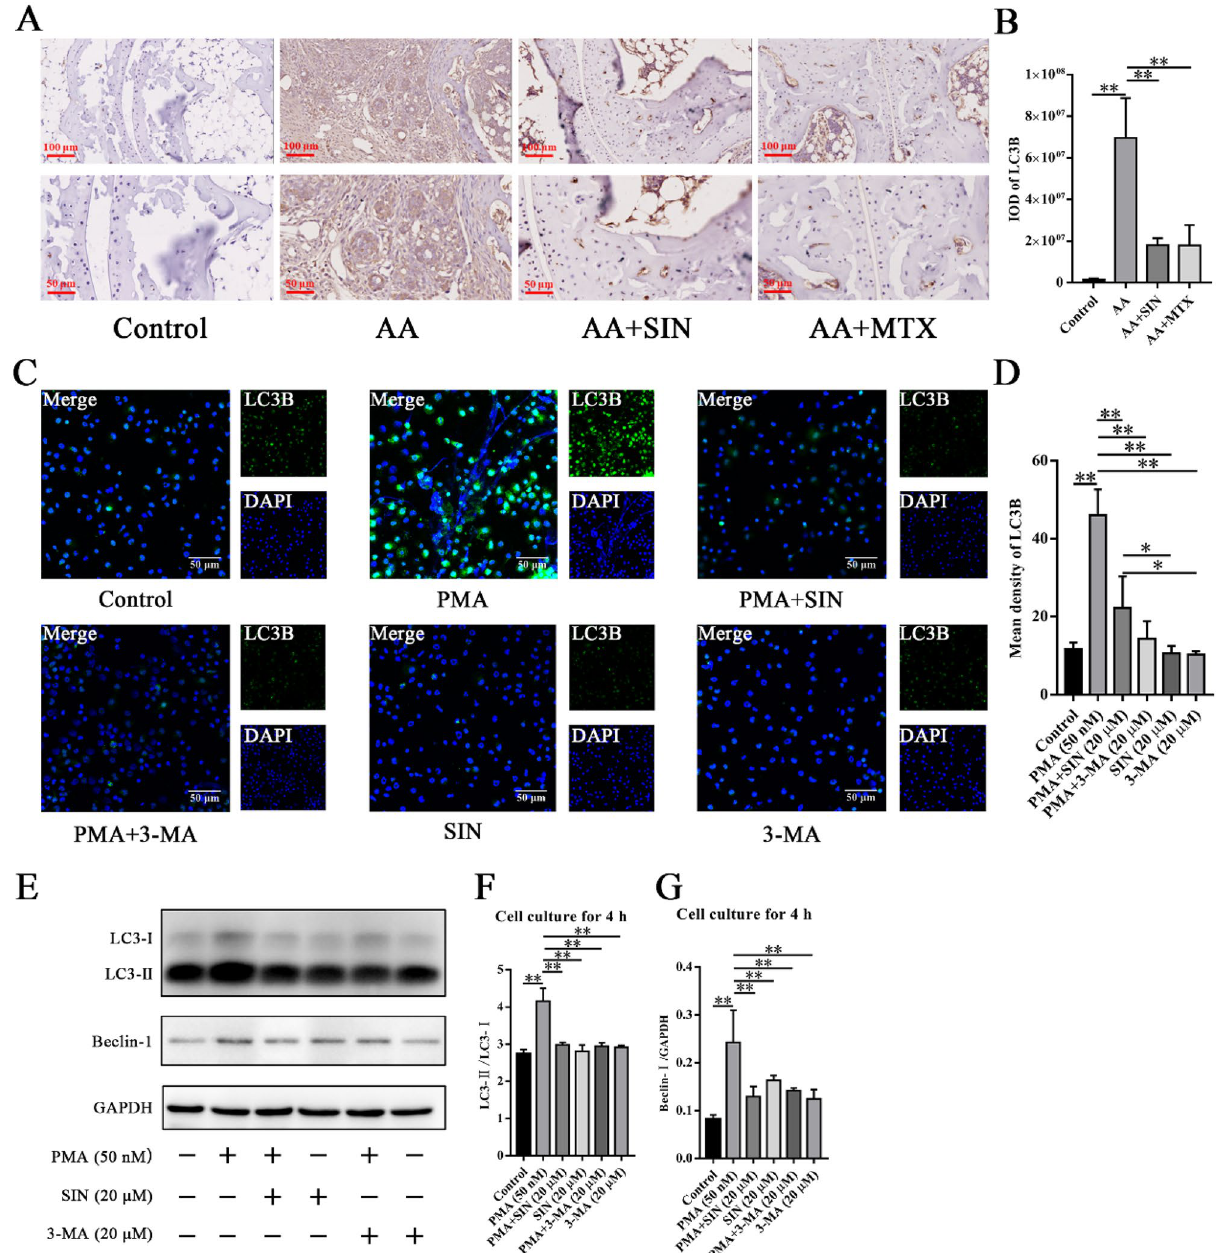
Figure 8. Sinomenine inhibited neutrophil autophagy in vivo and in vitro. ( A ) IHC staining was used to determine the level of LC3B in ankle joint sections from mice. Representative images are shown. ( B ) The IOD of LC3B in ( A ). The data are shown as the mean ± SD (n = 3). “n = 3” represents three mice with representative joint diameters and arthritis scores that were selected from each group to prepare ankle joint tissue sections, and one representative picture of each mouse was used for quantification. ( C ) IF staining was used to determine the level of LC3B in neutrophils from each group. Representative images are shown. ( D ) The mean density of LC3B in ( C ). The data are shown as the mean ± SD (n = 3). ( E ) Western blot analysis of the levels of LC3 and Beclin-I in neutrophils with different treatments for 4 h. Representative images are shown. ( F ) ImageJ was applied to analyze the relative values of LC3-II/LC3-I in ( E ). The data are shown as the mean ± SD (n = 3). ( G ) Statistical analysis was applied to analyze the relative Beclin-I/GAPDH ratios in ( E ). The data are shown as the mean ± SD (n = 3). *p < 0.05 , **p < 0.01